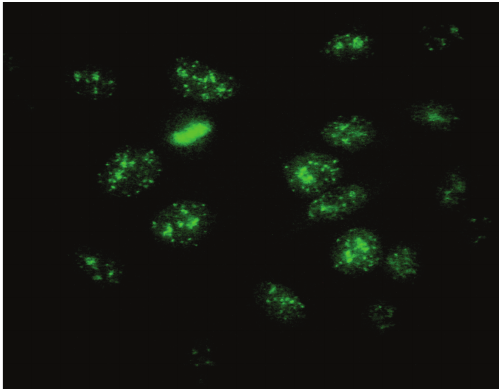
Figure 1: Indirect immunofluorescence on HEp-2 cells performed with an autoimmune hepatitis serum and demonstrating cen- tromere